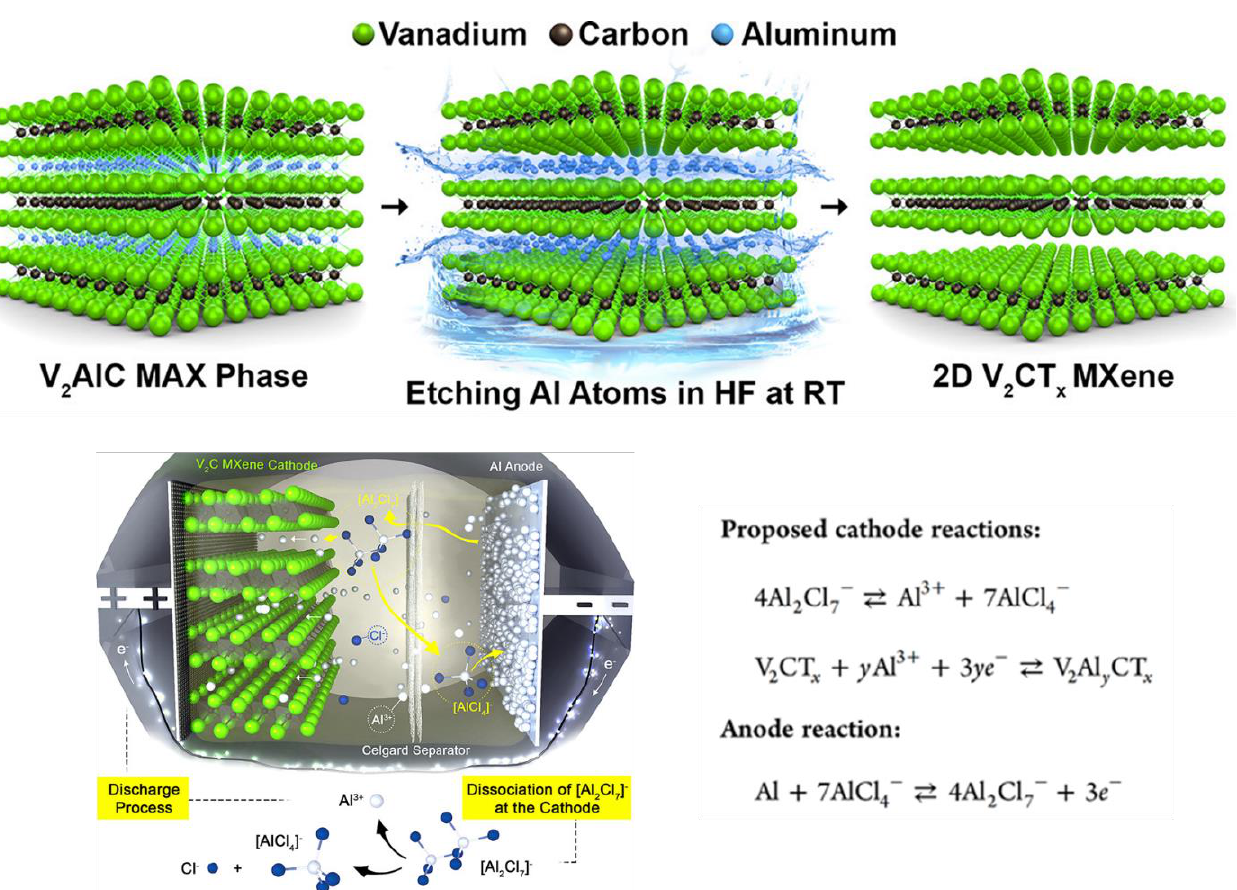
Figure 7. Schematic illustration of the process of selective etching used to synthesize V 2 CT x MXene from the V 2 AlC MAX phase followed by interlayer expansion of ML-V 2 CT x MXene via TBAOH intercalation and the proposed mechanism for an Al battery with V 2 CT x MXene as the cathode during discharge in ionic liquid electrolyte. Adapted with permission [22]. Copyright 2017, American Chemical